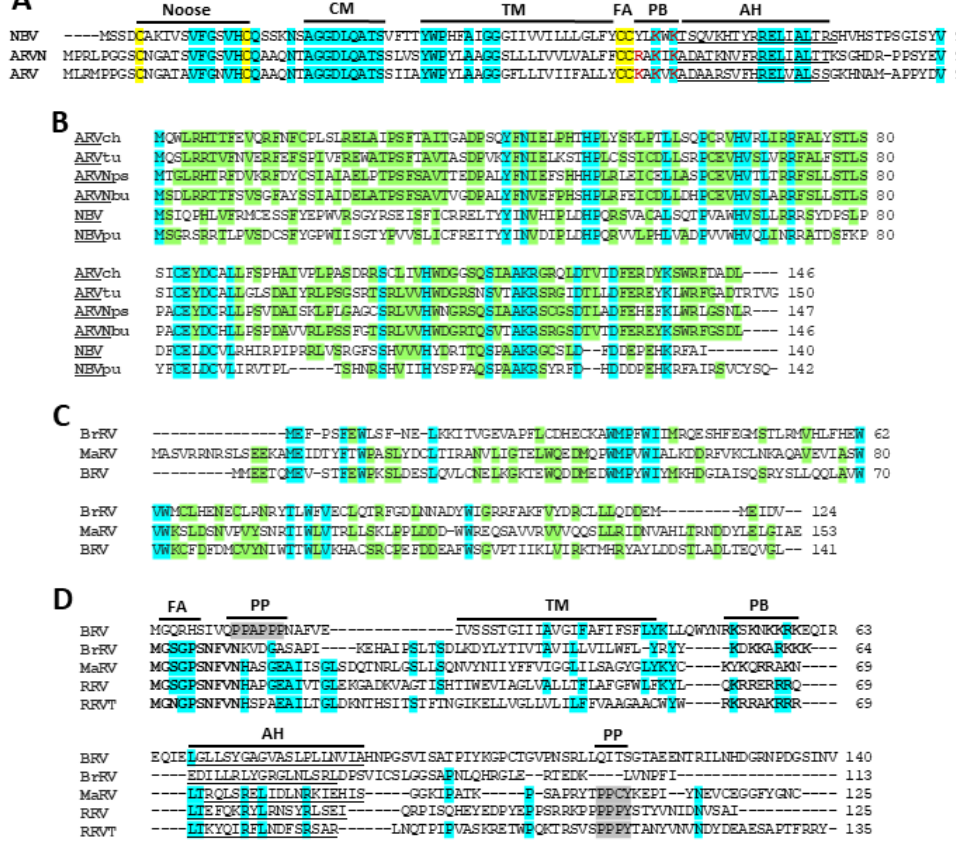
Figure 4. Sequence alignments and hallmark features of orthoreovirus FAST proteins and secondary polycistronic genome segment ORFs. ( A ) Sequence alignments of the p10 FAST proteins encoded by the indicated three orthoreovirus species or proposed species. Residues conserved in all three species are highlighted in cyan while the four conserved cysteines are highlighted in yellow. Hallmark p10 motifs are indicated: Noose, cystine noose formed by Cys9-Cys21; CM, conserved multimerization motif; TM, transmembrane domain; FA, palymitoylated di-cysteine motif; PB, polybasic motif with basic residues in red boldface; AH, predicted amphipathic helix underlined. ( B ) Sequence alignments of the p17 proteins encoded by the indicated fusogenic orthoreovirus species or proposed species. Lowercase labels denote isolates within a species: ch and tu are chicken and turkey isolates of ARV; bu and ps are bulbul and psittacine isolates of ARVN; Pu is the Pulau isolate of NBV. Residues conserved in all alignments are highlighted in cyan. Residues in p17 that are conserved in at least one isolate from two of the three virus species are shaded green. ( C ) Sequence alignments of the p16 proteins encoded by the indicated fusogenic orthoreovirus species or proposed species. Residues conserved in all alignments are highlighted in cyan. Residues shaded green are conserved in two of the three virus species ( D ) Sequence alignments of the p13, p14, and p15 FAST proteins encoded by the indicated five orthoreovirus species or proposed species. Alignments were generated using Clustal Muscle and manually adjusted to align the indicated hallmark structural and functional motifs of FAST proteins: FA, fatty acid myristoylation motif (GXXXS); TM, transmembrane domain; PB, polybasic motif, basic residues in boldface; AH, predicted amphipathic helix (underlined); PP, polyproline motifs include a PPXY motif in p13/p14 and a polyproline helix (PPAPPP) in p15, shaded grey. The N-terminal decapeptide conserved in p13/p14 is in boldface. Residues conserved in three or more sequences are highlighted in cyan.